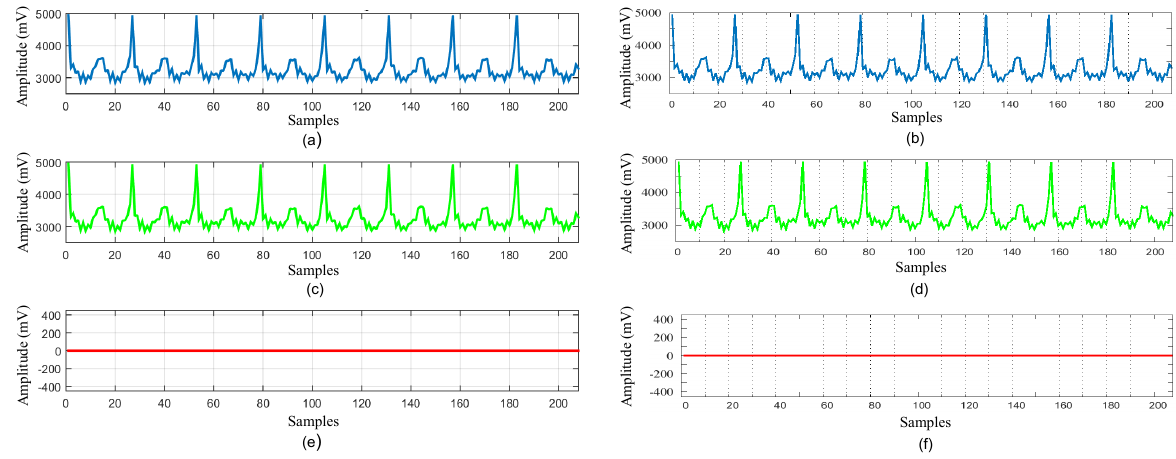
Figure 12. Comparison of measurements for image reconstruction between the PC and RPi4. ( a ) Measurements correspond- ing to the calibration plane using the PC, ( b ) Measurements corresponding to the calibration plane using RPi4, ( c ) Second round of calibration-plane measurements using the PC, ( d ) Second round of calibration plane measurements using RPi4, ( e ) Differences between first and second-round measurements using the PC, ( f ) Differences between first and second-round measurements using RPi4.